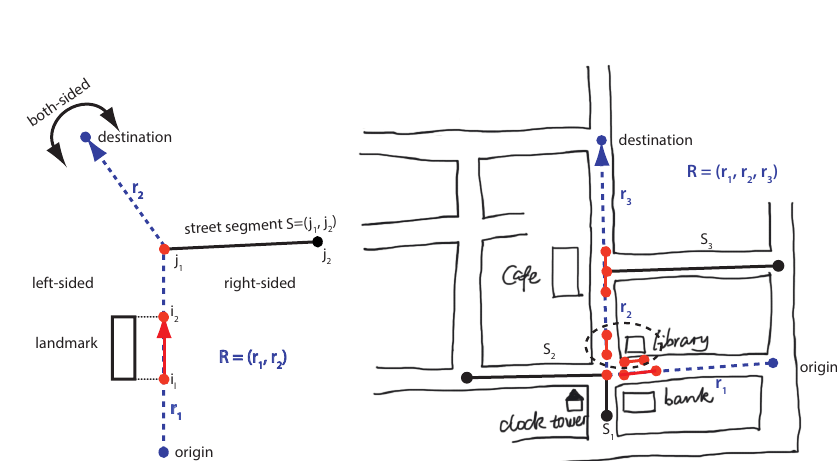
Figure 6: Definition of linear order relations (left) and an example of analyzing both-sided linear order relations (right). The two projections of library to route R are marked in circle.